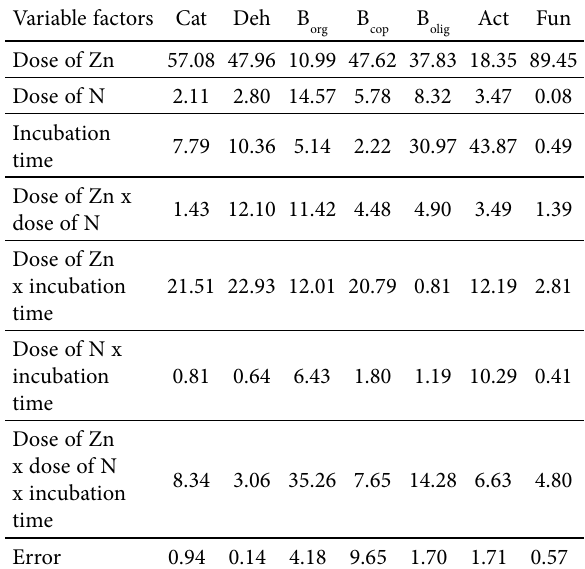
Table 1. Percentage of the observed variation η 2 in the soil contaminated with